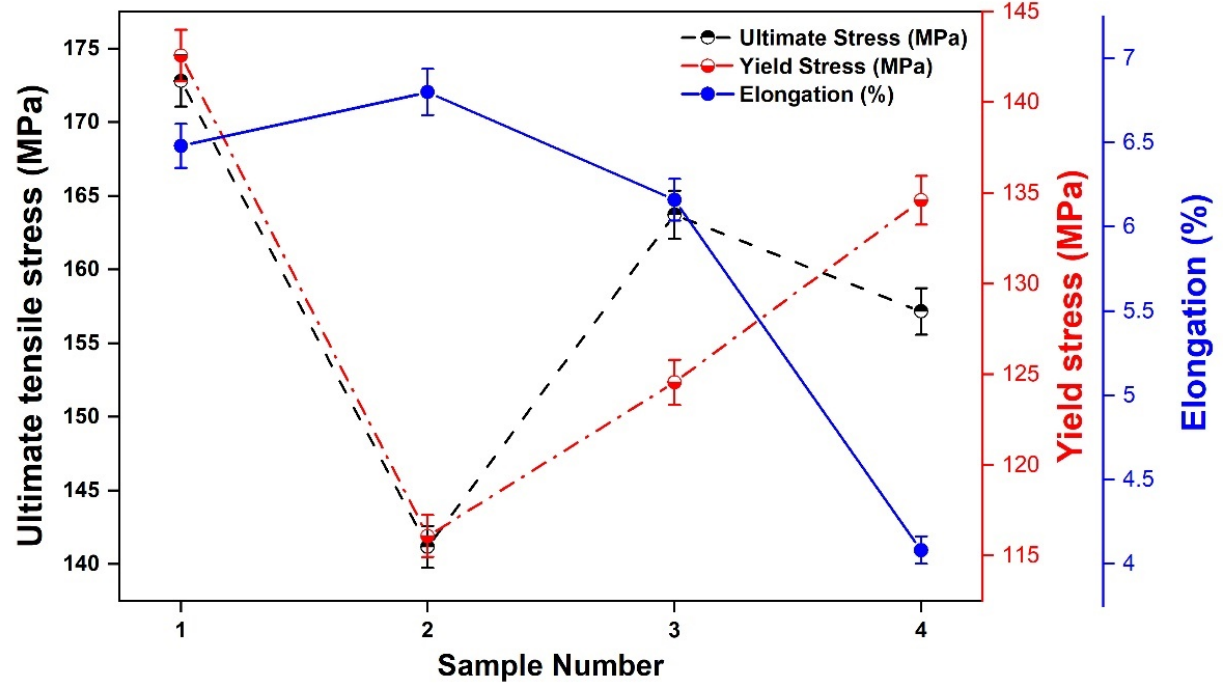
Figure 5. Tensile test properties measured for different sample compositions.